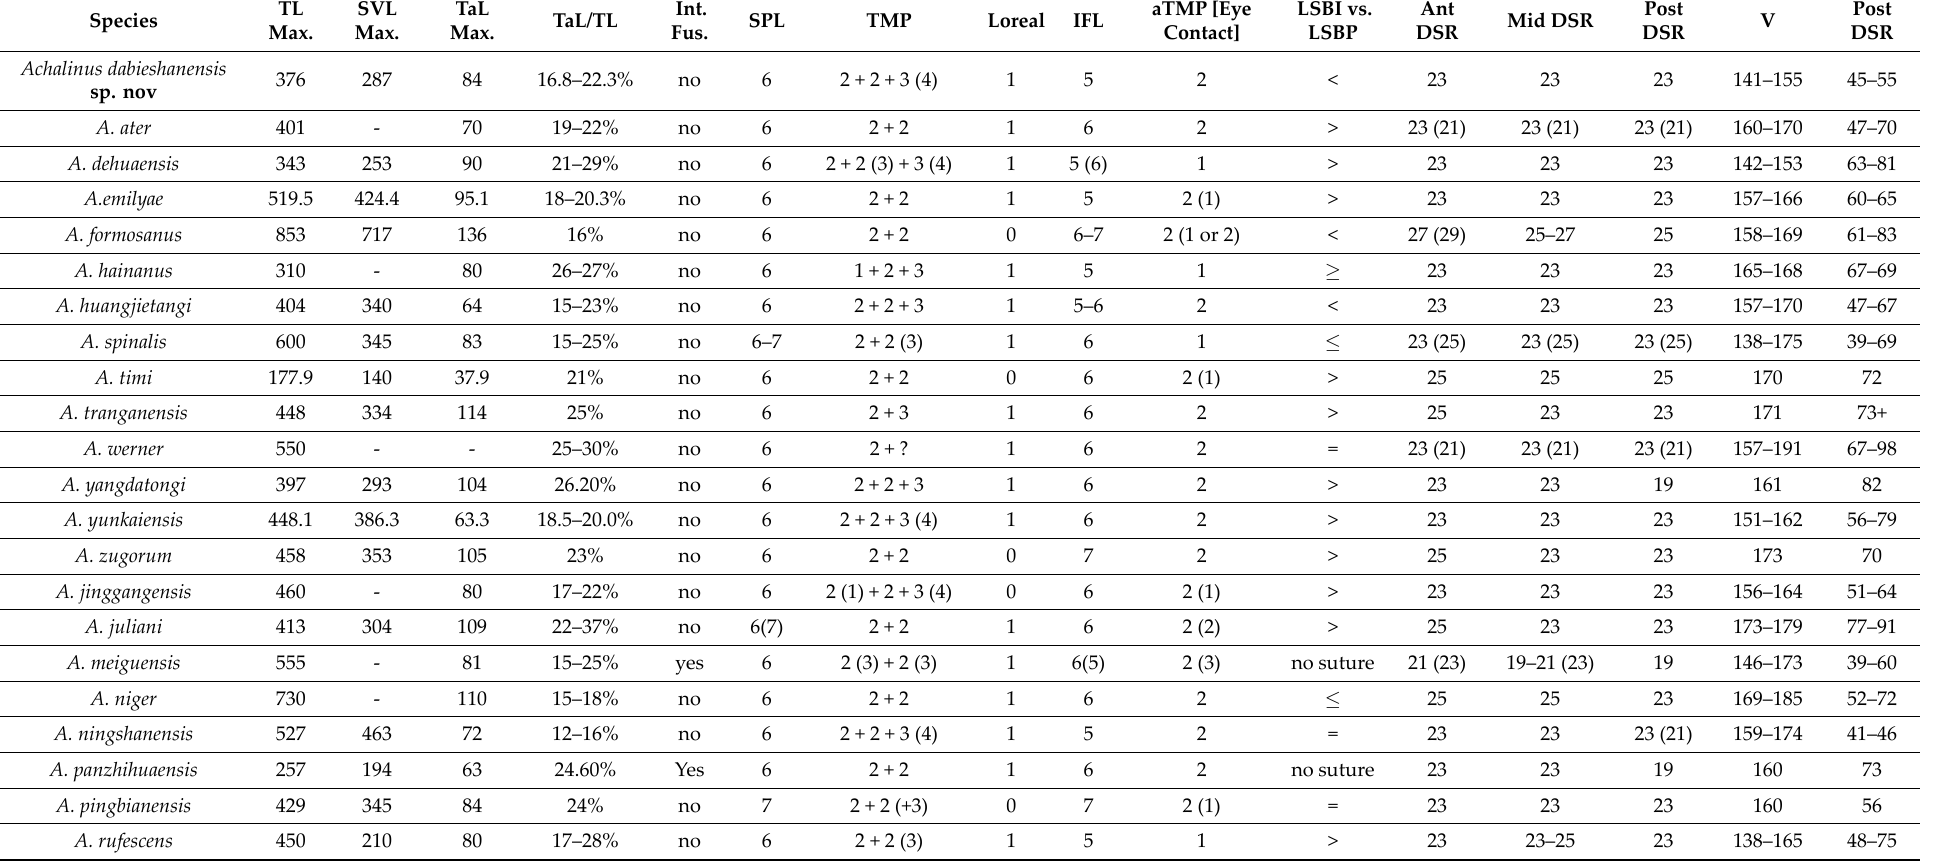
Table 4. Comparisons of main morphological characters among Achalinu dabieshanensis sp. nov.